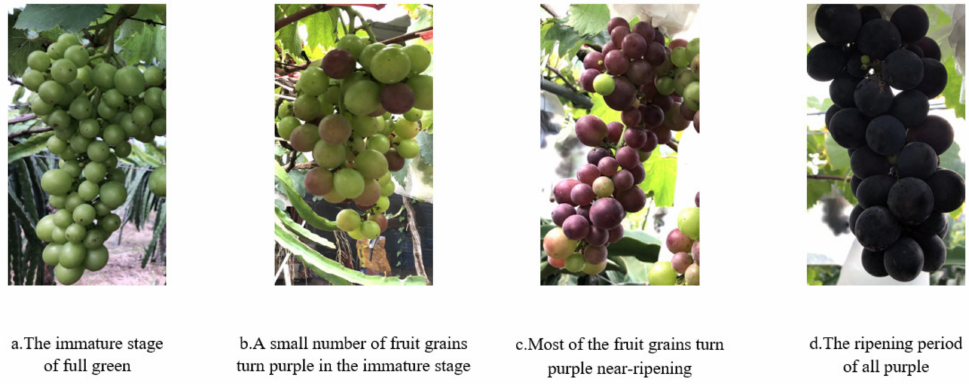
Figure 1. Images of grapes of four maturity